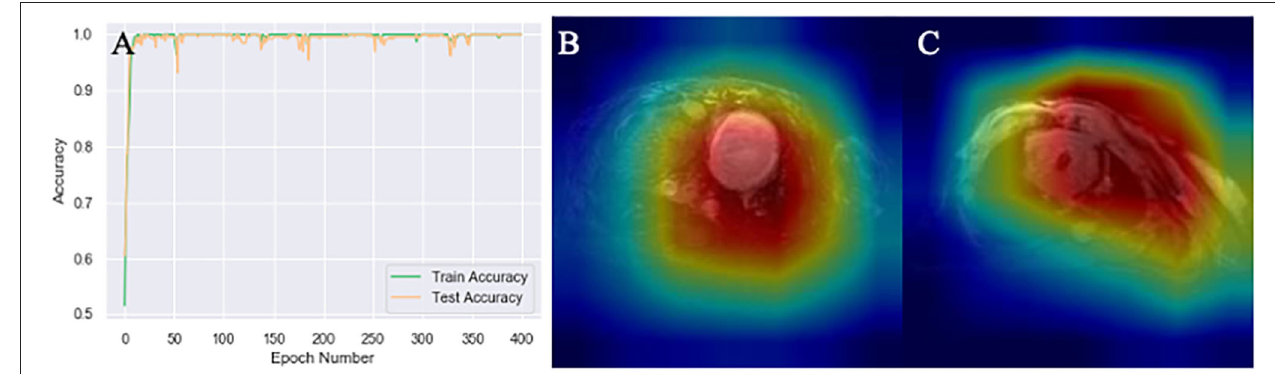
FIGURE 3 | Mouse MRI heatmaps and training curves generated by MobileNetV2. (A) Classification accuracy curve. The test accuracy was at 100% after several epochs that stabilized the model. (B,C) Heatmaps generated by Gcam from acute myocardial infarction (MI) and control mice, respectively.